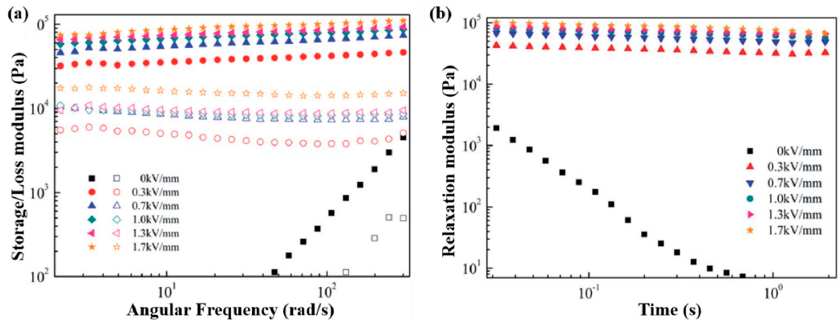
Figure 13. ( a ) Storage and loss modulus (closed symbol: G ′ , open symbol: G ″ ) as a function of angular frequency and ( b ) relaxation modulus calculated by Schwarzl equation for the SiO 2 /PPy based ER fluid (10 vol %) (Kim et al. [95], © The Royal Society of Chemistry, 2016).